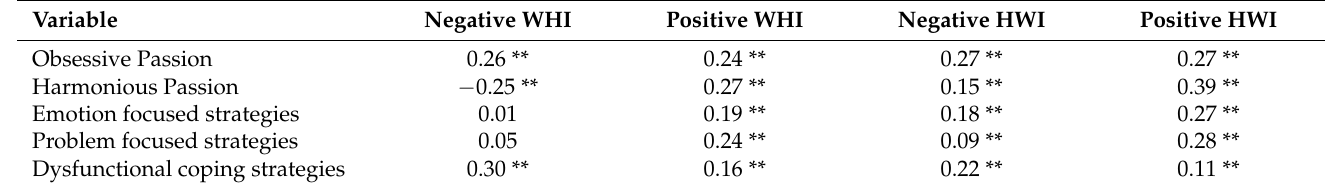
Table 4. Correlations between passion for work and strategies of coping with stress and the home– work and work–home